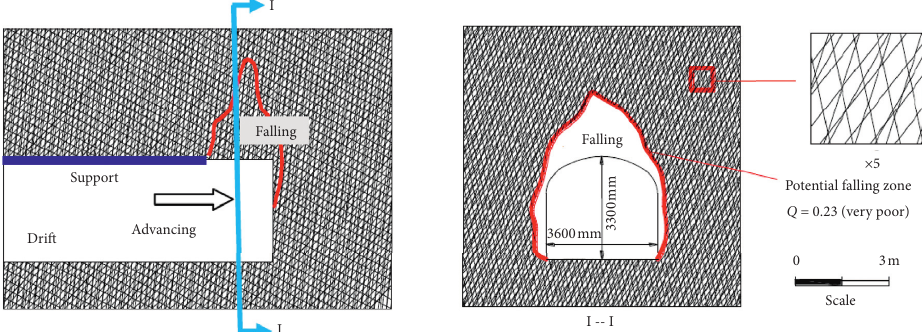
Figure 4: The shape and height of falling in the unsupported drift according to field observation.